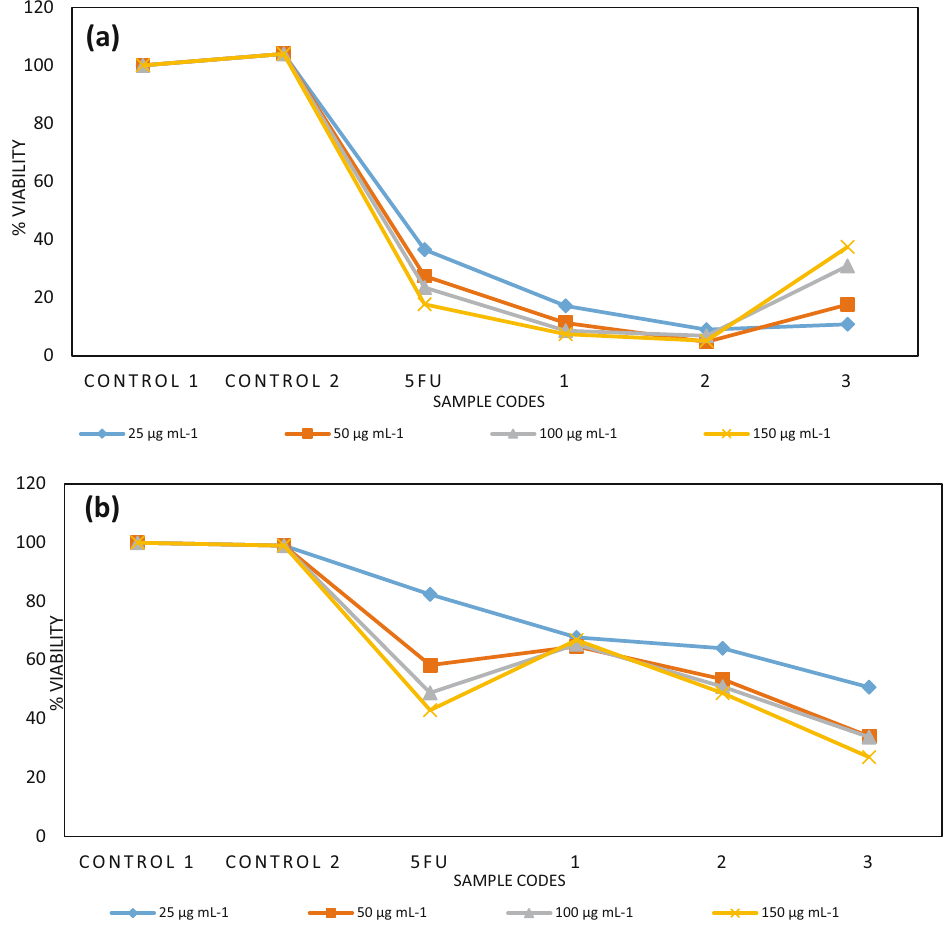
Figure 4: Plot of percentage ( % ) viability against the complexes showing concentration - dependent pro fi